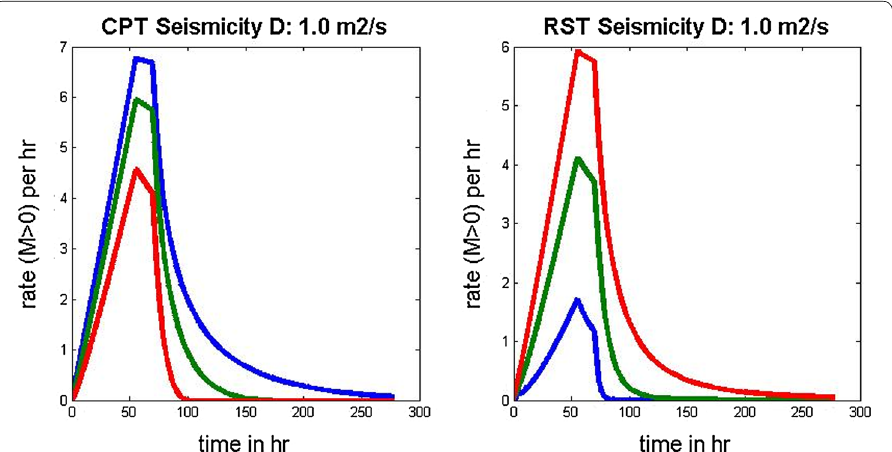
Fig. 6 Post-shut-in behaviour of seismicity (diffusivity 1.0 m 2 /s) calculated with CPT and RST with variable = C CPT and C RST for pressure dropping to zero at 70 h after start of injection. Left panel (identical to Fig. 5, left panel ) shows the CPT results for C CPT ( blue 1 kPa; green 5 kPa; red 10 kPa). Right panel shows the RST results for C RST ( blue 0.2 kPa; green 1 kPa; red 5 kPa). Note that with the proper choice of C CPT and C RST , the